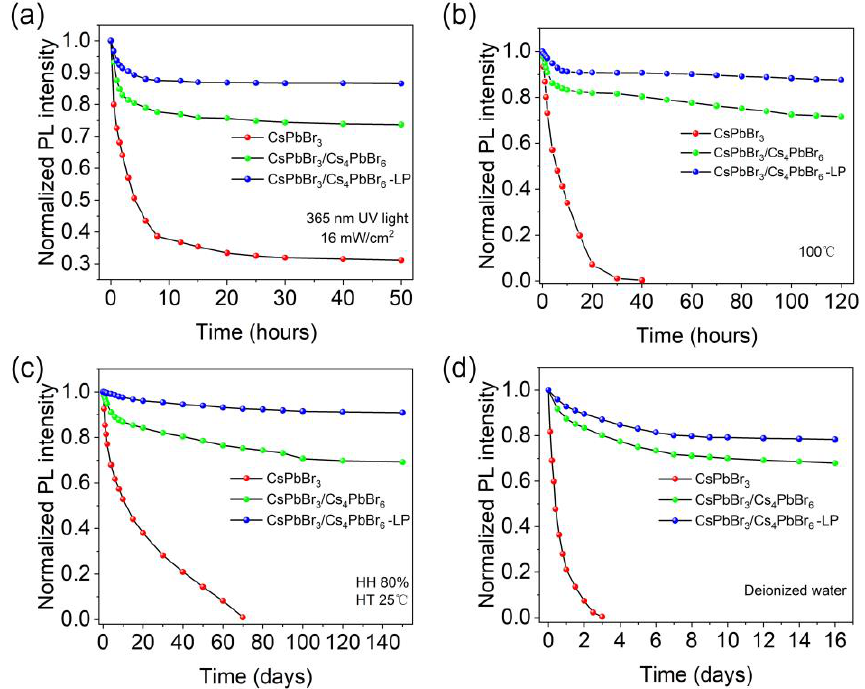
Figure 7. UV photostability, thermotolerance, storage stability, and polar solvent stability of pure CsPbBr 3 QD powders, CsPbBr 3 /Cs 4 PbBr 6 microcrystals, and CsPbBr 3 /Cs 4 PbBr 6 – LP microcrystals: ( a ) CsPbBr 3 QD powders, CsPbBr 3 /Cs 4 PbBr 6 microcrystals, and CsPbBr 3 /Cs 4 PbBr 6 –LP